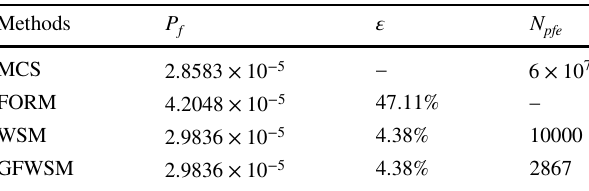
Table 2 Estimated failure probability, relative error and the number of performance function evaluations of different methods on reliabil- ity analysis example 1 Methods